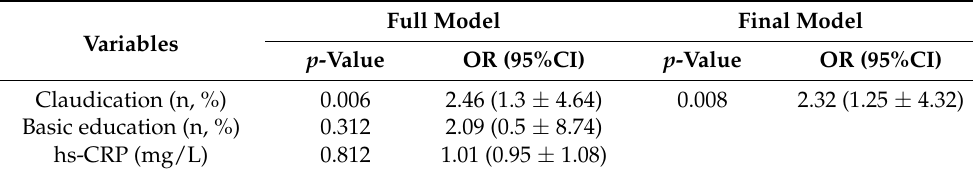
Table 5. Results of stepwise backward logistic regression analysis of an ABI ≤